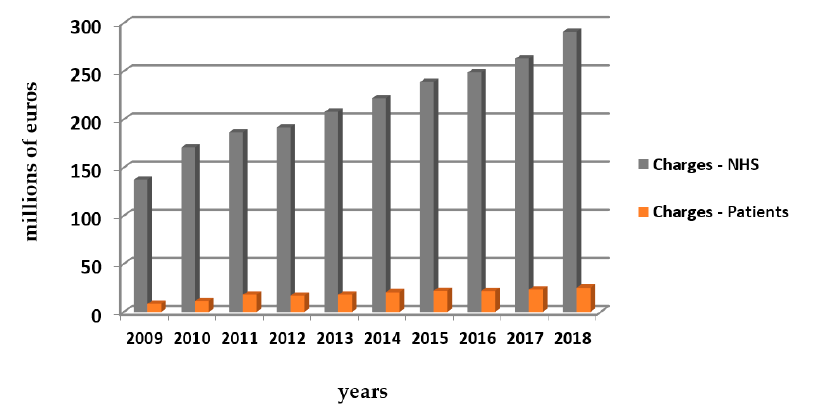
Figure 6. Outpatient sales of insulin and non-insulin drugs within the NHS in Continental Portugal—in value (millions of euros) since 2009 to 2018. Source: Raposo J., 2020 [13].